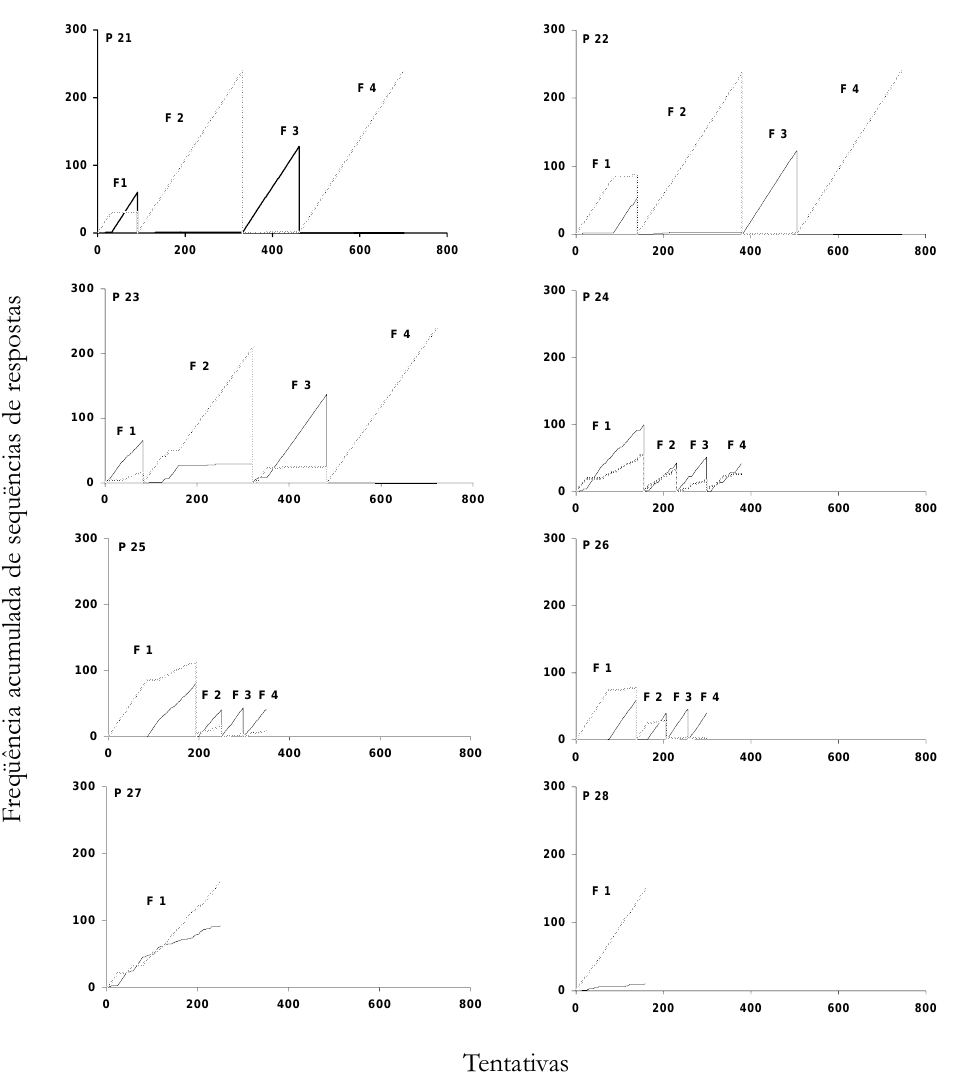
Figura 1. Freq(cid:252)Œncia acumulada de seq(cid:252)Œncias de respostas corretas (linha s(cid:243)lida preta) e incorretas (linha tracejada cinza), para cada participante (P), durante cada fase (F) experimental. Quebras na curva acumulada indicam mudan(cid:231)as de fase. Na Fase 1 a seq(cid:252)Œncia correta (refor(cid:231)ada) era estabelecida por refor(cid:231)o diferencial. Concorrentemente com a seq(cid:252)Œncia estabelecida na Fase 1 (correta em todas as fases), nas Fases 2 e 4 a regra discrepante especificava uma seq(cid:252)Œncia incorreta e na Fase 3 a regra correspondente especificava uma seq(cid:252)Œncia tambØm nas curvas acumuladas serªo descritas juntamente com os dados das Tabelas 2 a 4. A Tabela 2 5 mostra os dados da Fase 1 dos